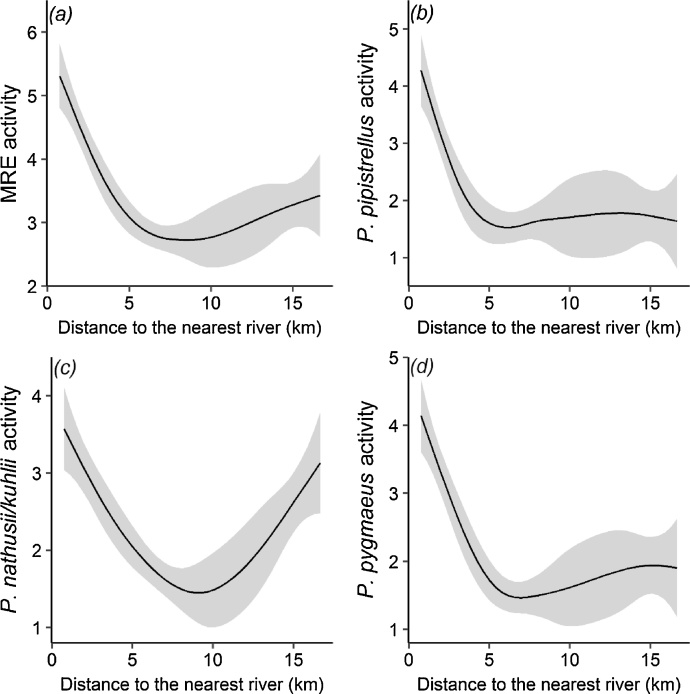
Non-linear relationship predicted by the most parsimonious GAMs (see Table 2) between the activity of (a) mid-range echolocator bats (MRE guild); (b) Pipistrellus pipistrellus; (c) Pipistrellus nathusii/kuhlii; and (d) Pipistrellus pygmaeus and the distance to the nearest river. Model predictions are represented by the black solid lines with 95% confidence interval indicated in grey.